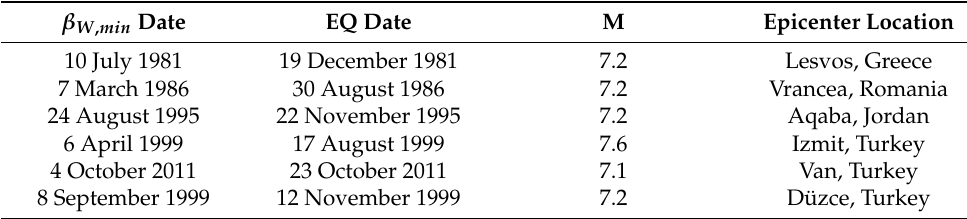
Table 1. The dates of the five almost simultaneously (within 3 months) observed minima in the limiting geographical areas A 5 and A 6 of the 5-core and the 6-core of the area N 50 together with the strong EQs that they had preceded. a They are marked with (red) open circles in Figure 2. In the last line, a local minimum that was also observed before Düzce EQ was also added; see Figure